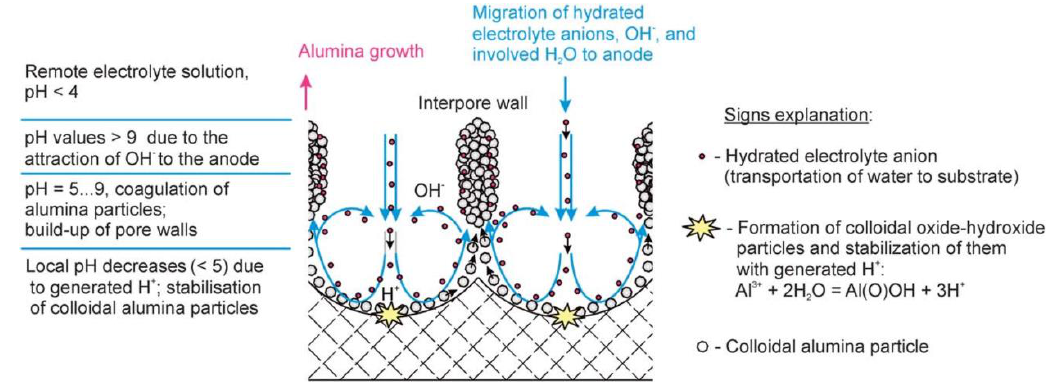
Figure 23. Schematic representation of the PAA formation mechanism according to the electroconvection-assisted colloidal self-organization model. Coherent motion of electrolyte ions and charge-stabilized colloidal alumina particles is responsible for the formation of equal-sized cells and the long-continued growth of PAA in the direction perpendicular to the metal surface. Different pH regions serve for stabilization of the colloidal suspension against aggregation very near the Al substrate and for the further coagulation and formation of polycrystalline interpore walls at a certain distance from the pore bottoms. Reproduced with permission from [16]. Copyright 2011 The Royal Society of Chemistry.